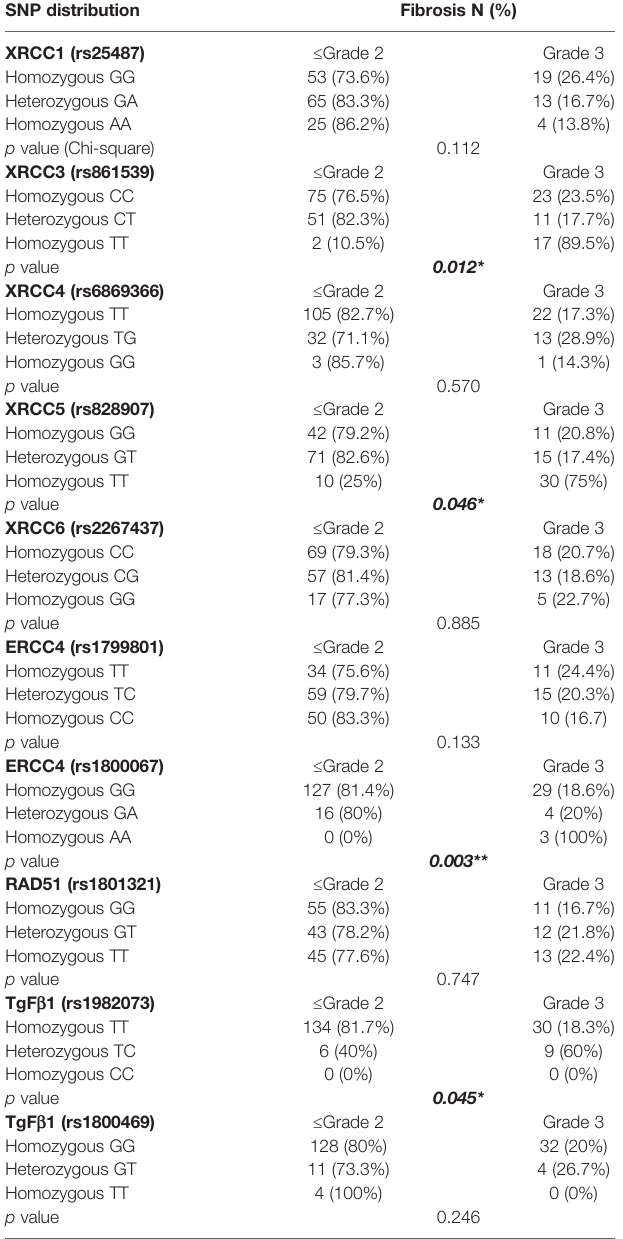
TABLE 2 | SNP distribution and toxicity status. TABLE 3 | Multivariate analysis of genotypic variables and clinical characteristics with risk of subcutaneous fi